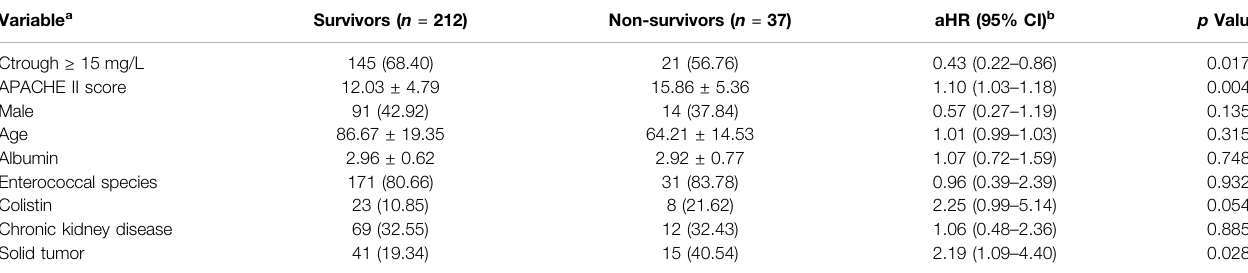
TABLE 5 | Multivariable Cox regression model for signi fi cant predictors of risk factors for 30-days mortality among all patients with enterococcal